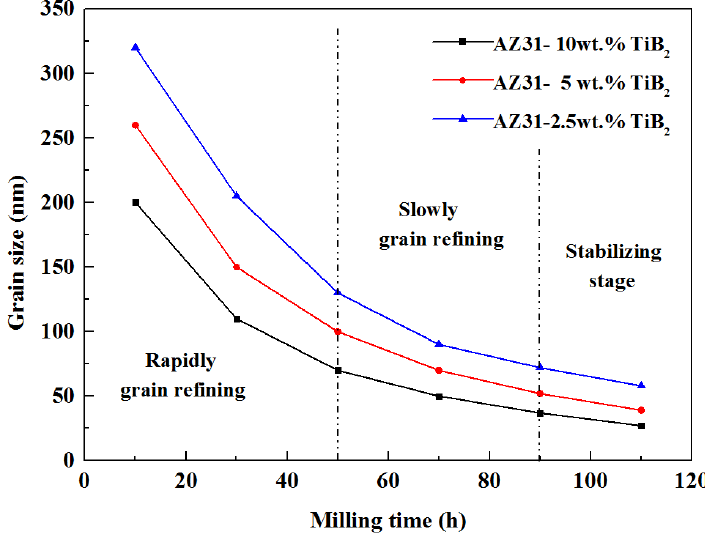
Figure 8. The grain size of the Mg matrix in the AZ31/TiB 2 composite powders, with different TiB 2 additions and after milling for different times.